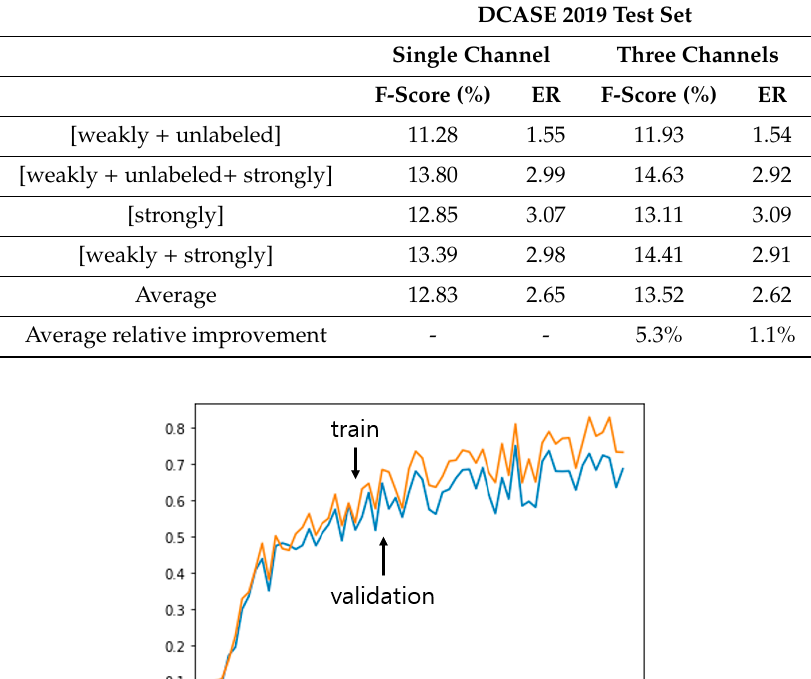
Table 4. SED results for the basic CRNN using derivative features (DCASE 2019 test set).